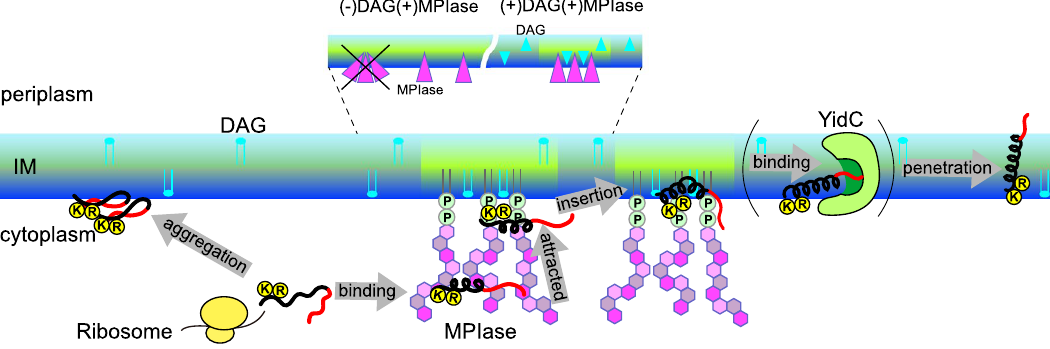
Figure 6. Schematic model of the membrane insertion of a small hydrophobic substrate protein in E. coli membranes. Besides the PE-rich propensity of the cytoplasmic leaflet in the inner membrane (dark blue), the presence of DAG (light blue) blocks spontaneous insertion by reducing the mobility of the acyl chains in the membrane core region (dark green). However, in the presence of MPIase together with DAG, the mobility is increased (light green). A protein (black: hydrophobic region, red: hydrophilic region) reaches the membrane surface in an unfolded state following its release from a ribosome. MPIase may assemble with DAG, probably to compensate for their shapes (shown in the close-up of the membrane indicated by dashed lines), and the sugar chain of MPIase captures the protein and inhibits protein aggregation. Subsequently, the side chains of the positively charged residues in the protein are attracted to the membrane surface through the pyrophosphate group of MPIase. This triggers the insertion of the protein into the membrane. The protein easily gains access to the loosened membrane core region. If the protein has a hydrophilic region, it is delivered to the hydrophilic groove of YidC. If the protein is hydrophobic enough, it can be embedded into the membrane without the help of